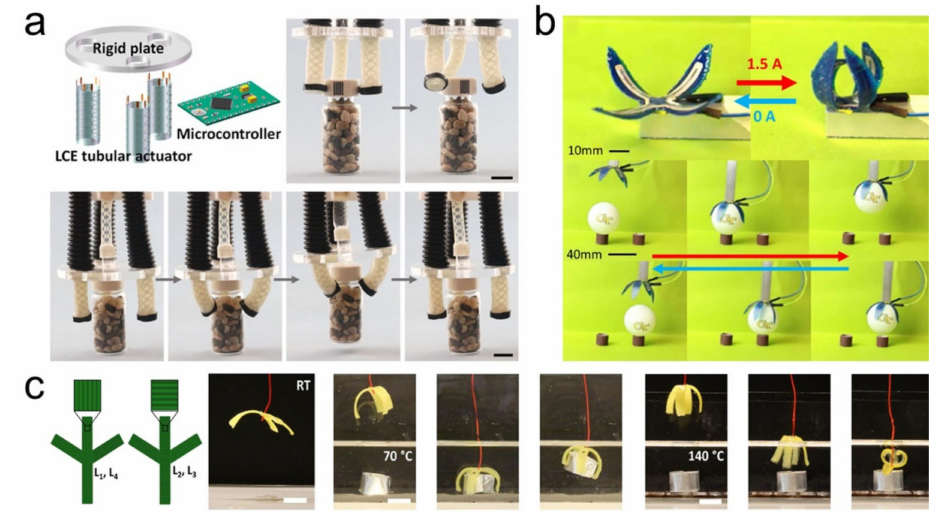
Figure 5. Grippers made by LCEs: ( a ) Multifunctional soft gripper with twisting and grasping functions [37] (Reproduced with permission from He, Q.; Wang, Z.; Wang, Y.; Minori, A.; Tolley, M.T.; Cai, S., Science Advances; Copyright 2019 American Association for the Advancement of Science.) ( b ) 4D printed four hinges soft robotic gripper picking and placing a ping pong ball [25] (Reproduced with permission from Roach, D.J.; Kuang, X.; Yuan, C.; Chen, K.; Qi, H.J., Smart Mater. Struct.; ©2018 IOP Publishing. Reproduced with permission. All rights reserved.) ( c ) A temperature-sensitive gripper. At a lower temperature (70 ◦ C), the gripper’s lower-temperature response layer deforms to grab and lift the object; at a higher temperature (140 ◦ C), the gripper’s higher-temperature response layer deforms and lowers the object [92] (Reproduced with permission from Davidson, E.C.; Kotikian, A.; Li, S.; Aizenberg, J.; Lewis, J.A., Adv. Mater.; Copyright 2020 John Wiley and